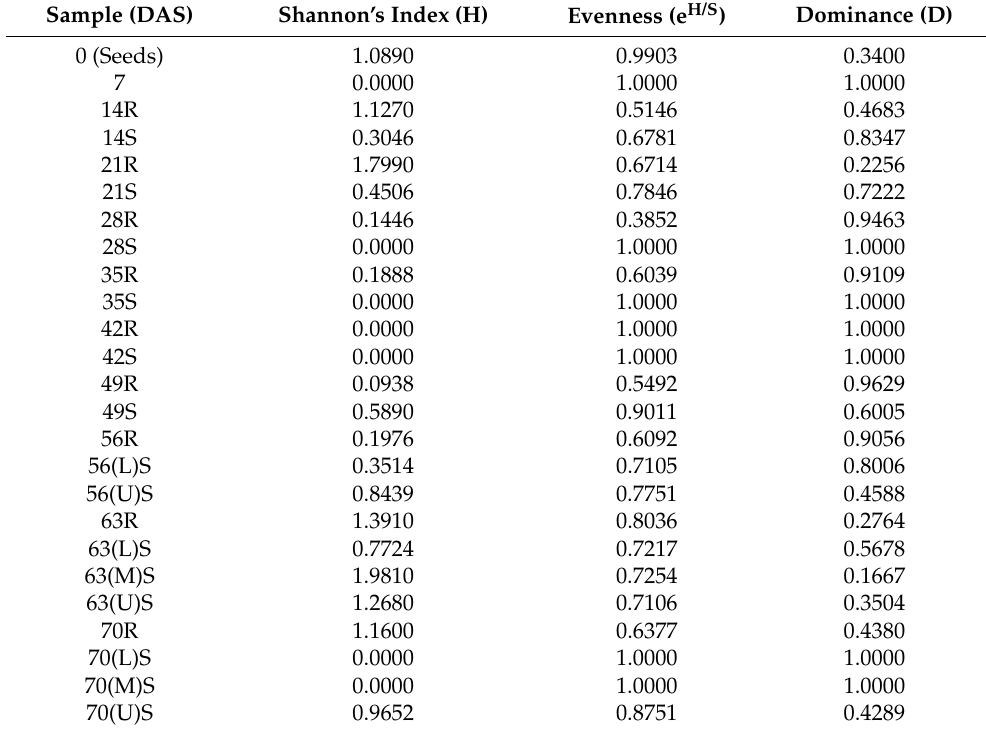
Table 1. Changes in diversity of total diazotrophic endophytic population with the growth of pearl millet under field conditions. R and S represent root and shoot,